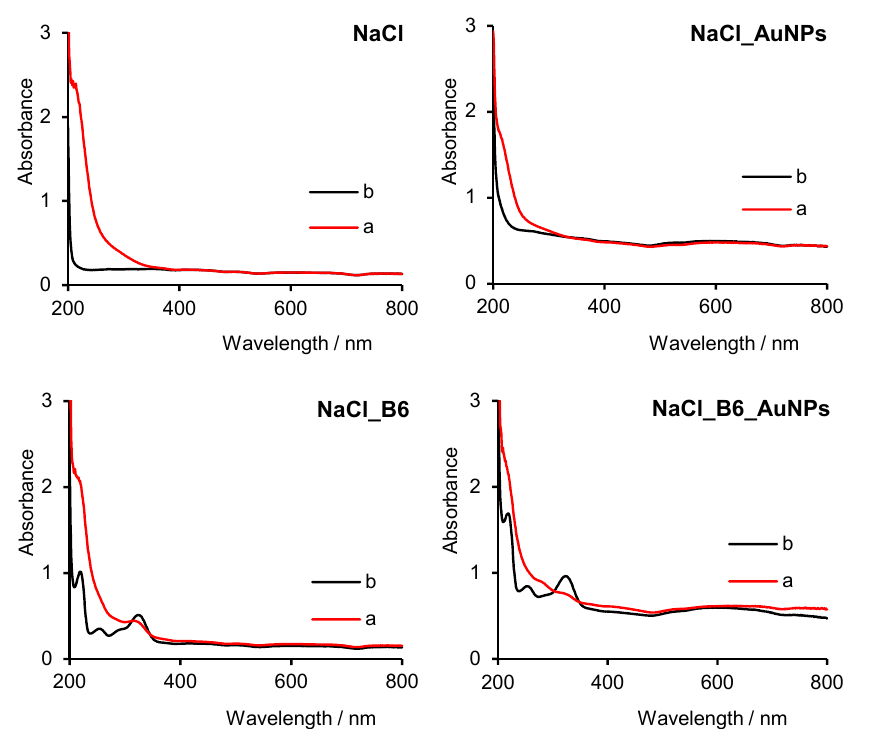
Figure 6. UV–Vis absorption spectra of electrolyte solution containing NaCl/B 6 /AuNP systems; b—before and a—after performing cyclic voltammetry.